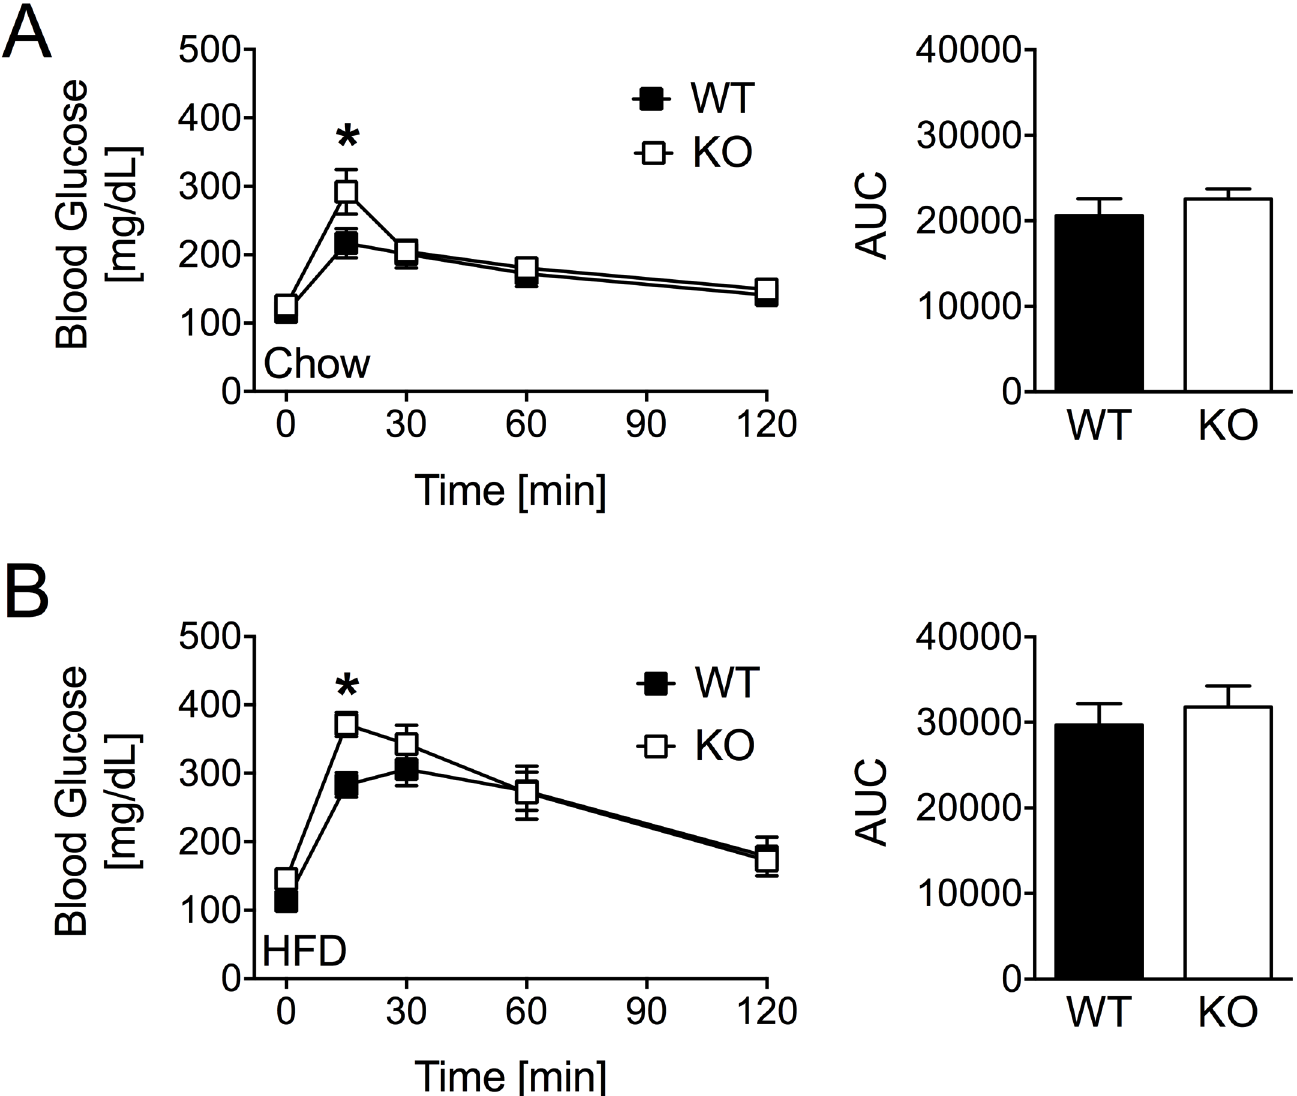
Fig 6. DUSP6 ablation impairs glucose tolerance. Intraperitoneal bolus injections of 2 g glucoseper kg body weight led to a temporary increasein glucoseexcursions15 min after injectionbut unchangedarea under the curve levels in (A) chow-fed(n = 9–10) and (B) 16-weeksHFD-fed DUSP6 WT and KO mice (n = 9). Means ± SEM; * p <